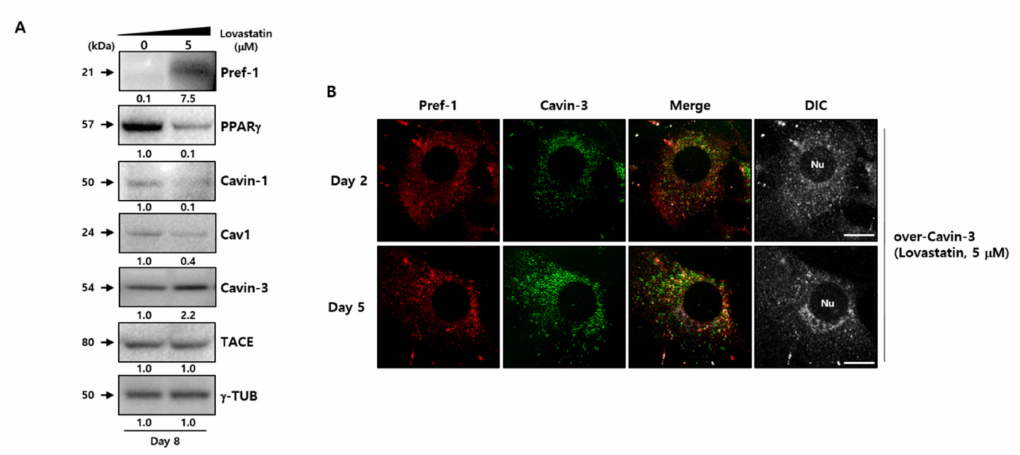
Figure 5. Cavin-3-dependent caveolar instability a ff ects the TACE-mediated Pref-1 shedding process. ( A ) Specific protein levels were determined by Western blot analysis using specific antibodies during adipocyte di ff erentiation with or without caveolar stability inhibitor, lovastatin, in normal 3T3-L1 adipocytes. γ -TUB was used as a control and the grouping of blots cropped from di ff erent gels. ( B ) Expression and subcellular localization of Pref-1 and Cavin-3 in over-Cavin-3 cells were validated during adipogenesis with or without lovastatin. The cells were fixed and stained with anti-Pref-1 (red) and anti-Cavin-3 (green) antibodies and observed with a confocal microscope. Scale bar = 5 µ